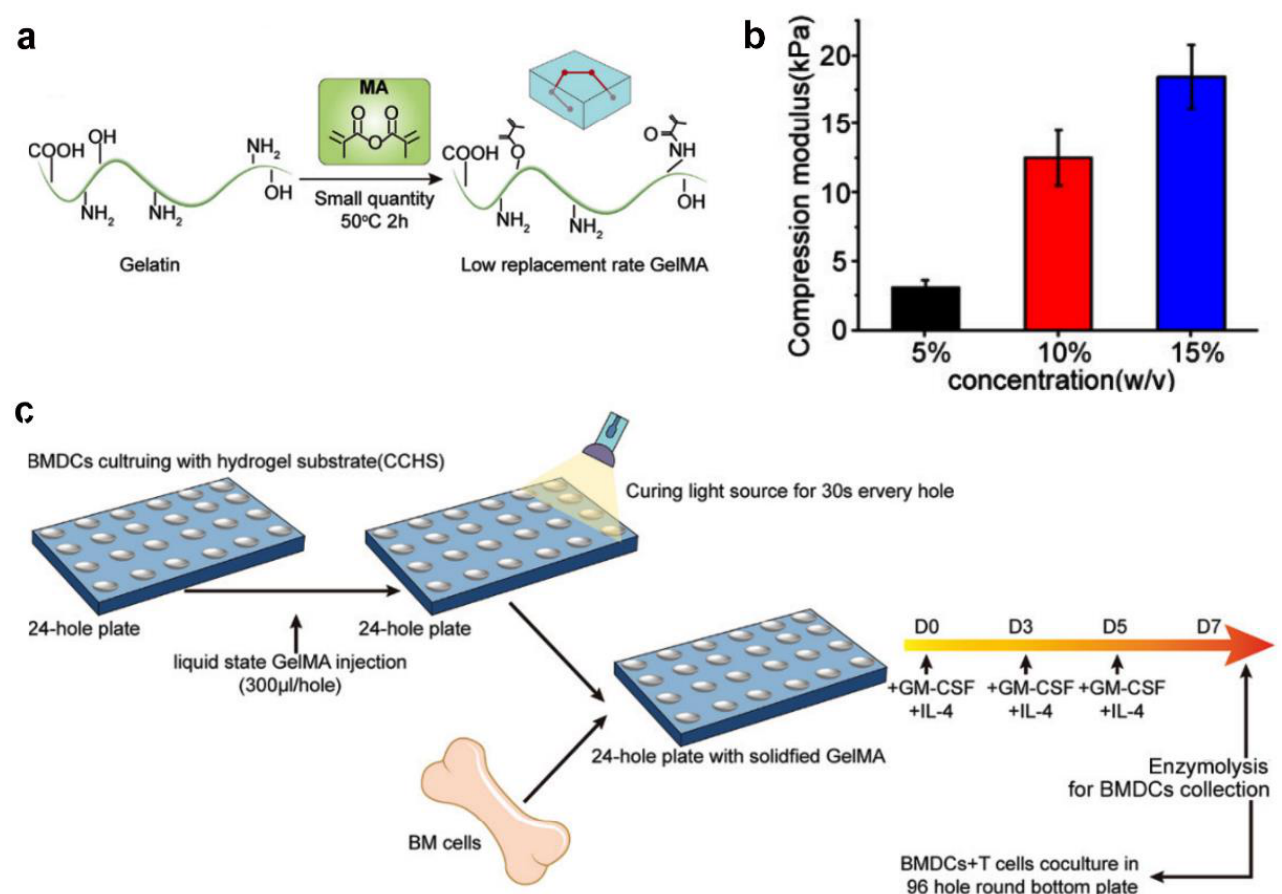
Figure 5. Photocurable hydrogel substrate for BMDC culture. ( a ) Synthetic equation of photo-crosslinked gelatin hydrogel substrate. ( b ) Compression modulus of photo-crosslinked gelatin hydrogel substrate with different concentrations. ( c ) BMDCs were cultured with GM-CSF and IL-4 from C57 mice on photo-crosslinked gelatin hydrogel substrate with different compression modulus. (Re- printed/adapted with permission from Ref. [31], 2022, Deng et al.).